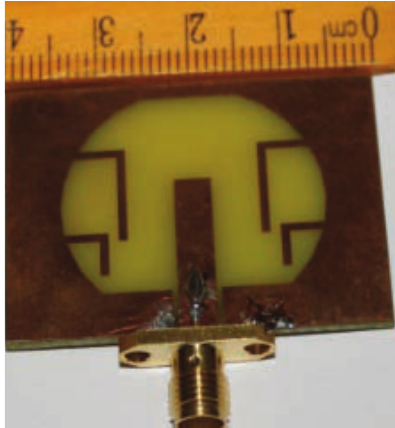
Figure 2: Antenna prototype.